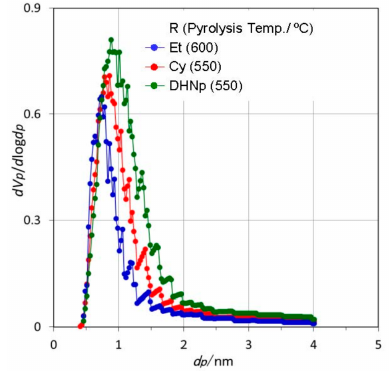
Figure 9. Micropore size distribution of ROSZ-derived amorphous Si–O–N